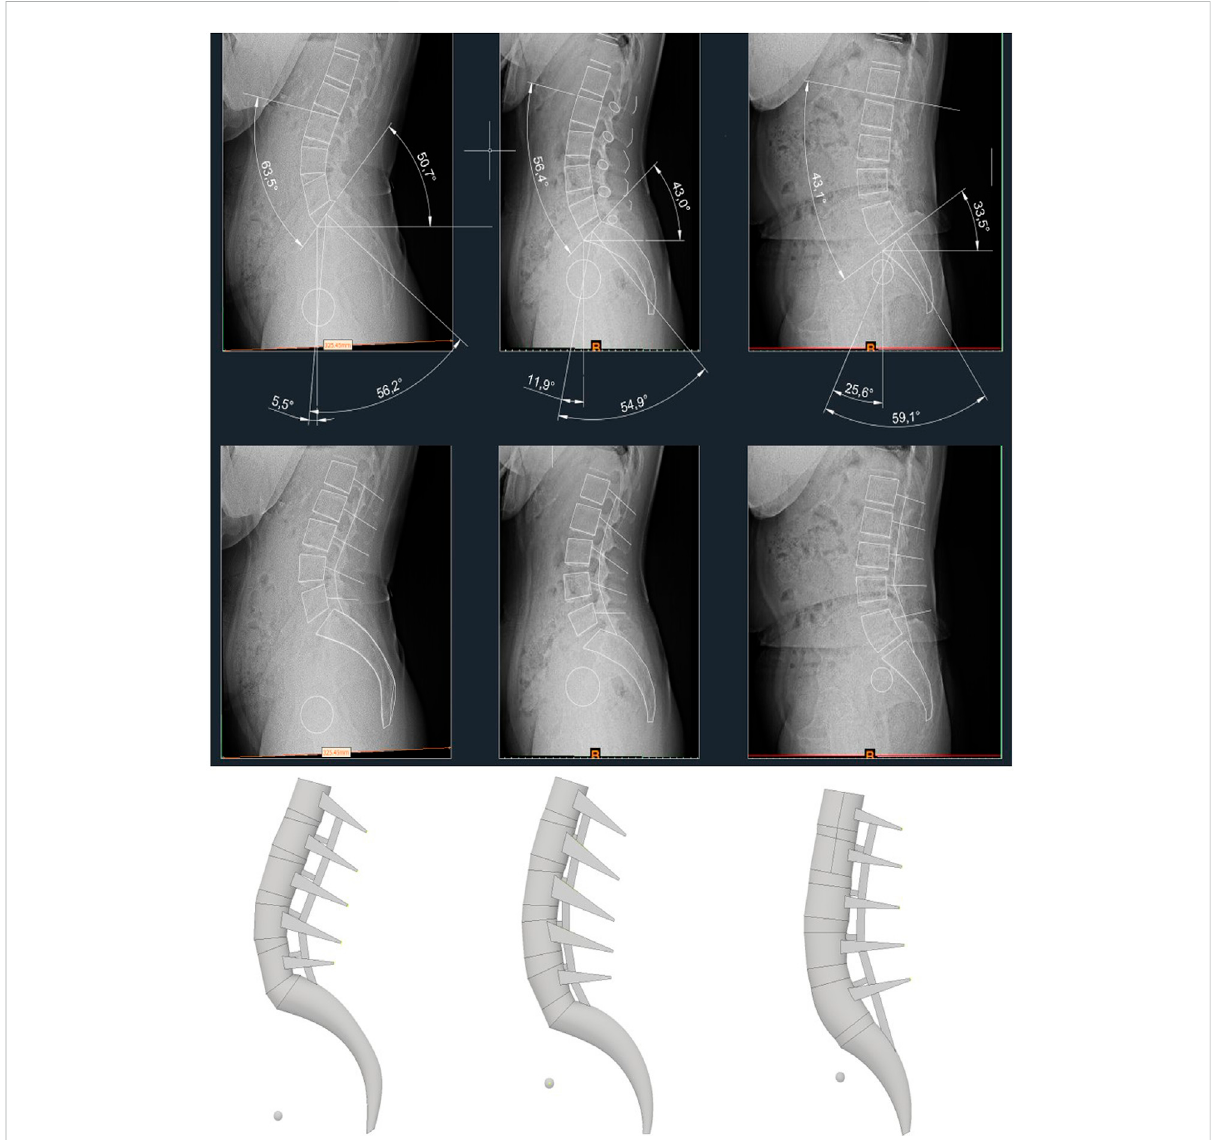
FIGURE 4 X-ray images displaying pelvic indicators of each representative model, and 3D models created based on